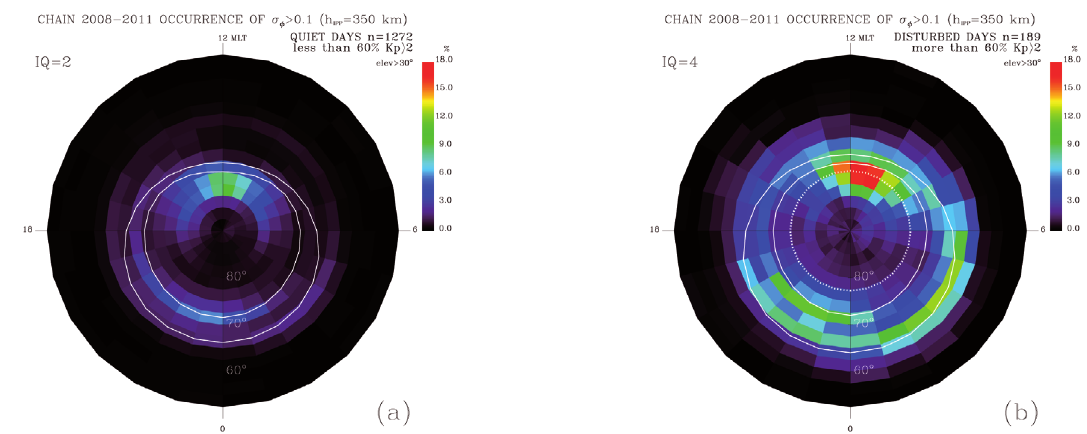
Figure 2. Phase scintillation occurrence maps for geomagnetically quiet (a) and moderately disturbed (b) days.